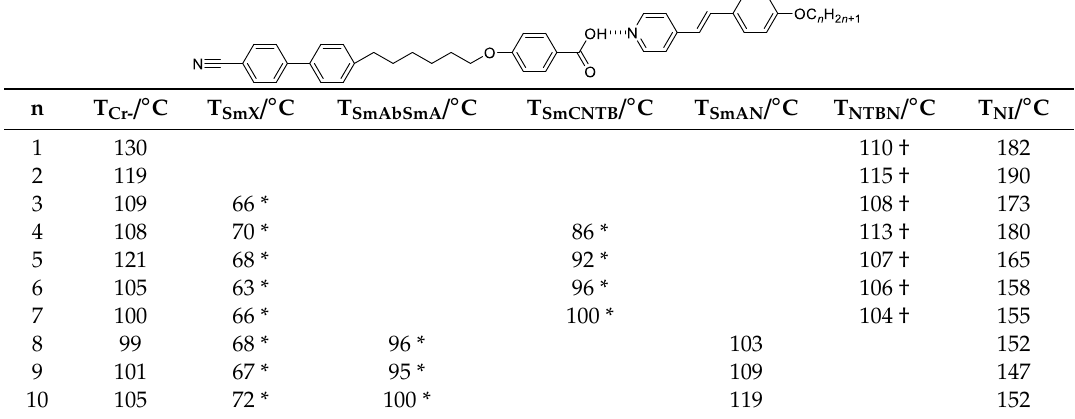
Table 1. Transition temperatures and associated entropy changes for the CB6OBA: n OS mixtures. *Temperature obtained from DSC cooling trace. †Temperature obtained from POM. ⁑